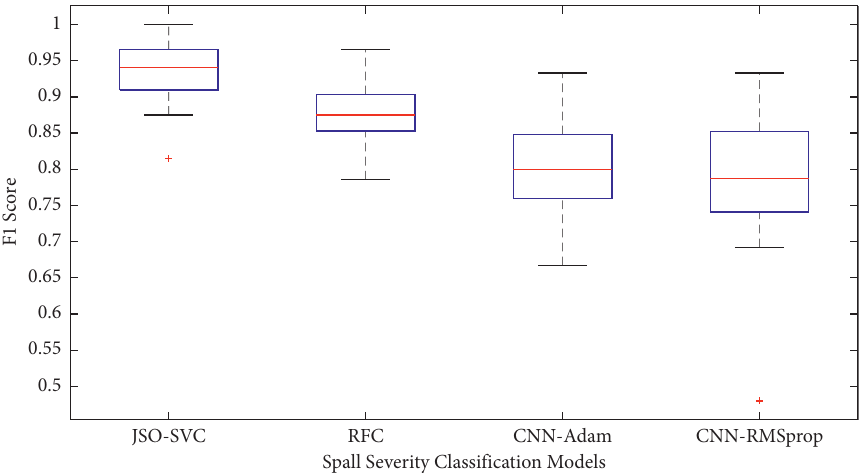
Figure 10: Boxplot of F 1 score values obtained from the employed machine learning models.